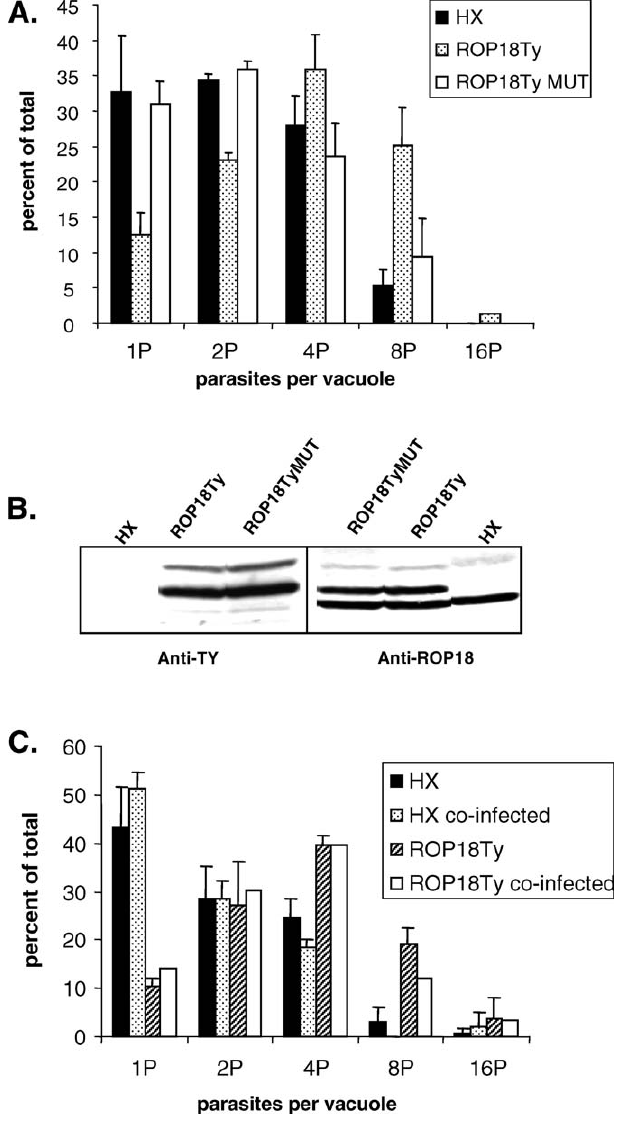
Figure 8. Overexpression of ROP18 Leads to Increased Intracellular Parasite Proliferation (A) Intracellular proliferation rate at 16 h post-invasion by wild-type tachyzoites (HX) and tachyzoites expressing an additional copy of ROP18- Ty (ROP18Ty) or a D 394 A-mutated version thereof (ROP18Ty MUT). This graph corresponds to one representative experiment and clearly shows a drift towards higher number of parasites per vacuole for the ROP18Ty parasites compared with that of either HX or ROP18Ty-MUT parasites. Error bars correspond to standard deviation between the triplicate coverslips. (B) Western blot of equal number of HX, ROP18Ty, and ROP18Ty MUT tachyzoites probed with anti-Ty or with anti-ROP18 showing similar expression of the Ty-tagged copy of ROP18 in both transfectants. (C) Proliferation rates of HX and ROP18Ty tachyzoites in a co-infection experiment, at 16 h post-invasion, showing that co-infection of a single cell does not modify the respective behaviour of either parasite type (HX or ROP18 are parasites alone in one cell, co-infected corresponds to vacuoles found in a cell containing also the other type, error bars correspond to standard deviation between triplicate coverslips).